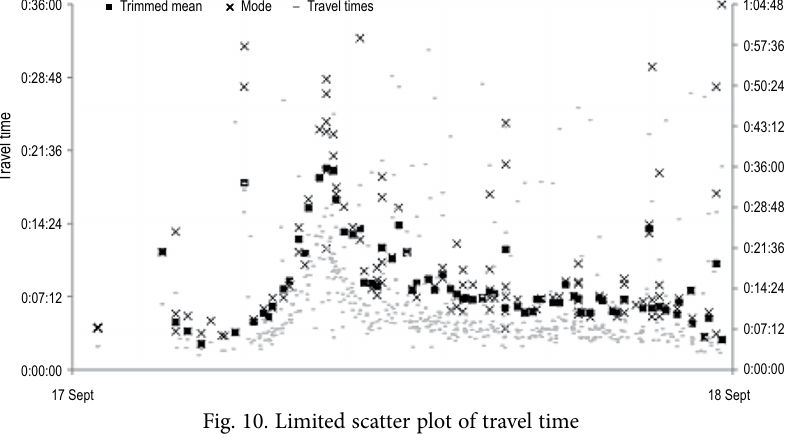
Fig. 10. Limited scatter plot of travel time